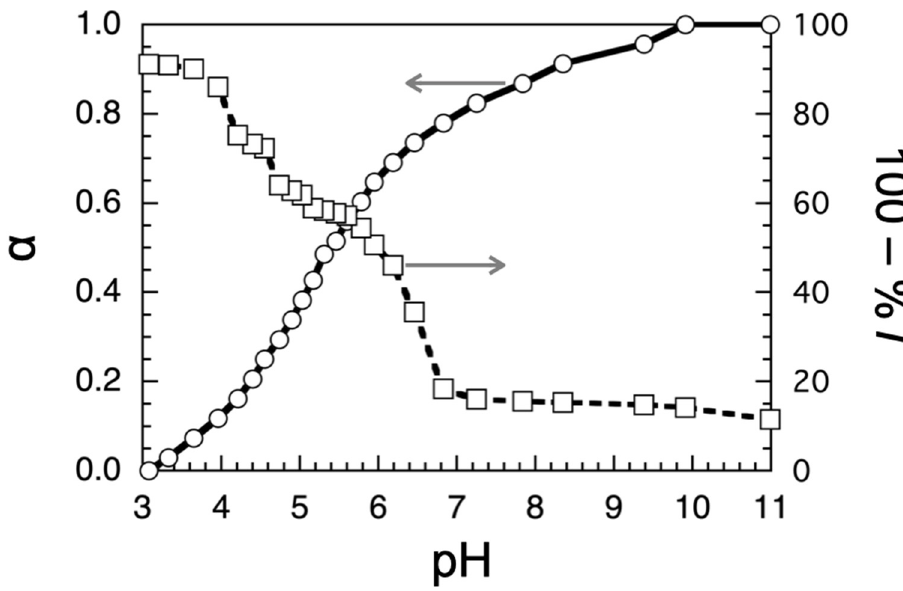
Figure 3. Turbidimetric and potentiometric titration data for an aqueous solution of poly(AH). The titration was performed by stepwise addition of 30 μ L of 0.10 M HCl starting from pH 9.9.